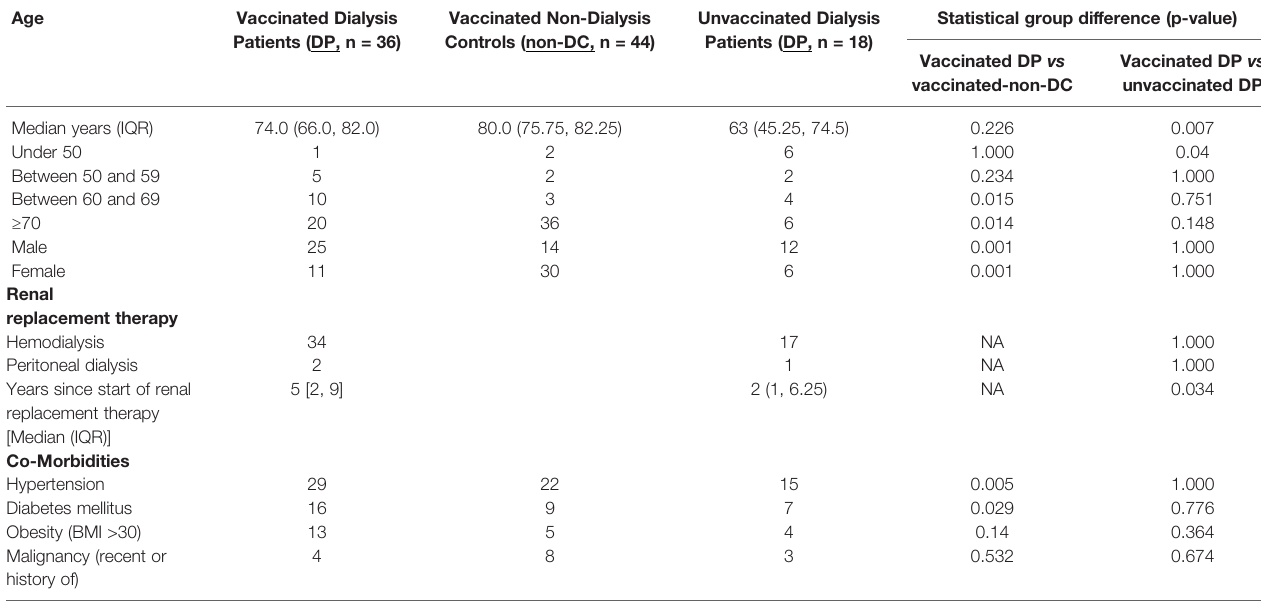
TABLE 1 | Patient characteristics. Age Vaccinated Dialysis